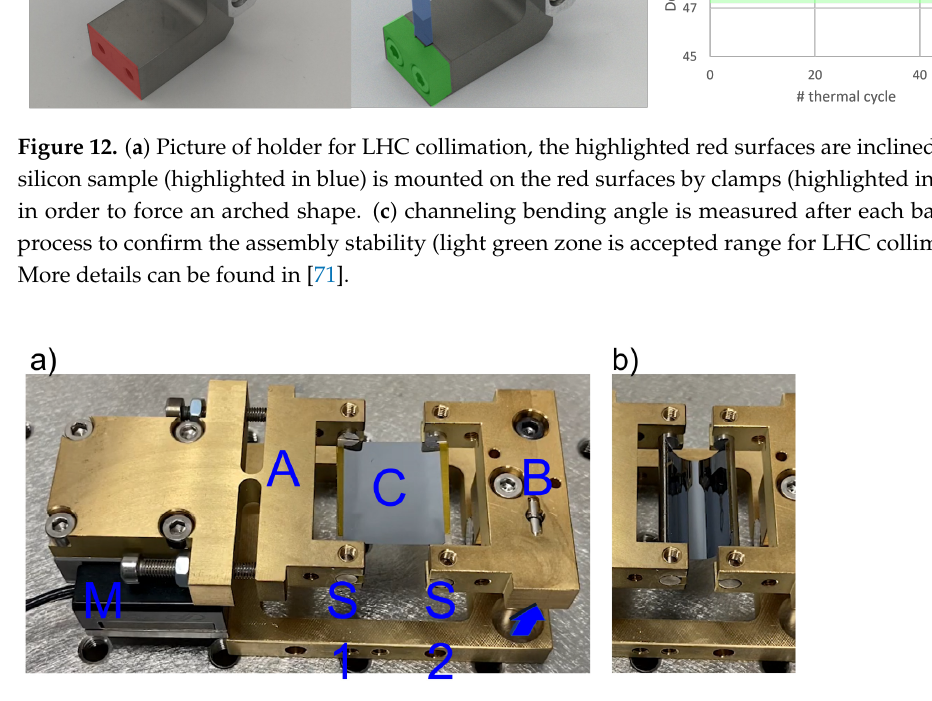
Figure 13. ( a ) Picture of the motorized holder for quasi mosaic curvature. Crystal (C) is glued on spines S1–2 and mounted on the holder. The high precision piezo actuated motor (M) moves A towards B, thus forcing the crystal to arch and bend as can be seen in ( b ). A second motor pushing along the arrow can be implemented in order to minimize torsion. Details in